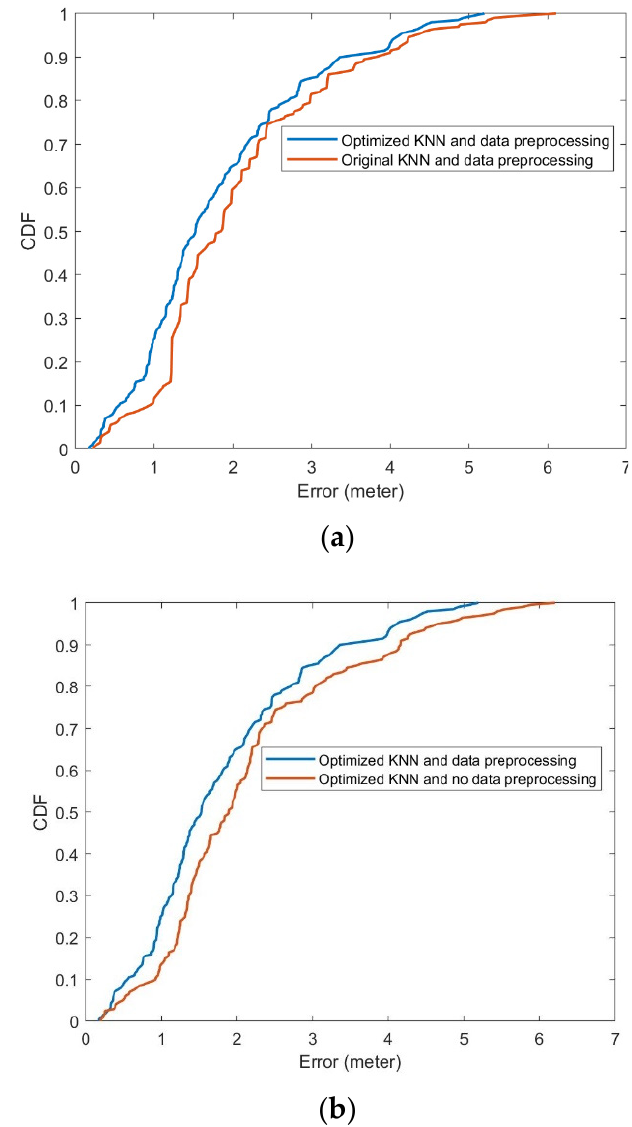
Figure 8. ( a ) Optimized KNN and data preprocessing, original KNN and data preprocessing. ( b ) Optimized KNN and data preprocessing, optimized KNN and no data preprocessing. Table 5. Detailed information of controlled